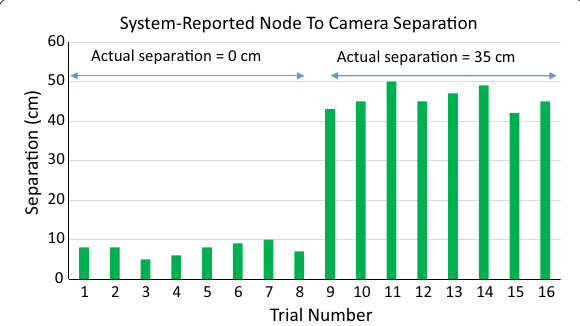
Fig. 7 Camera-to-node separation reported by the imaging system for eight simulated nodes. For each node, two actual separations (0 cm and 35 cm) were tested. The error in the reported distances was 9.2 mm with a standard deviation of 2.7 mm. Taking into account the 9 mm combined thickness of the collimator and camera housing, this corresponds to a true error of 0.2 2.7 mm ±